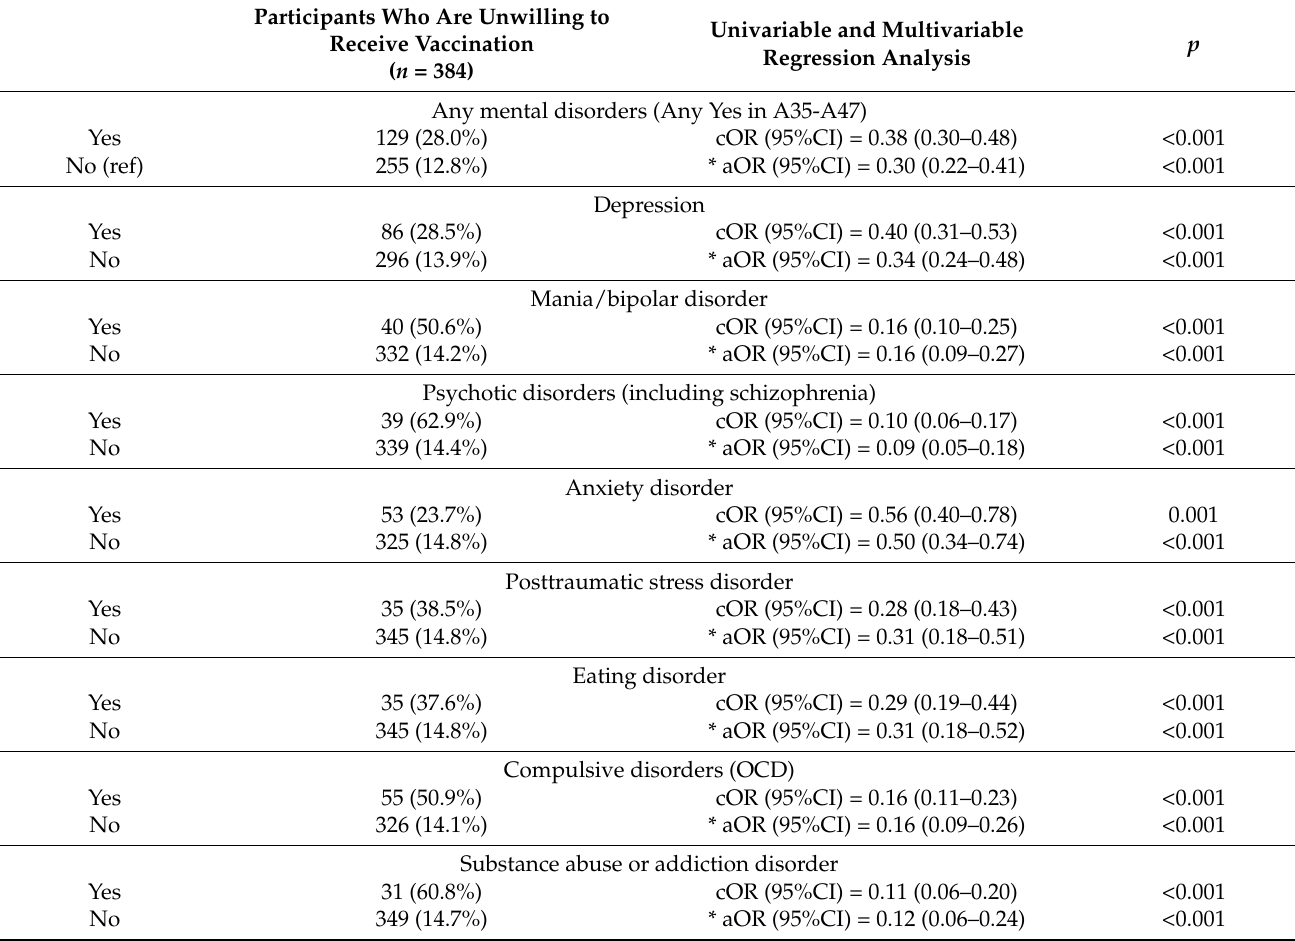
Table 4. Associations between mental disorders and COVID-19 vaccination intention ( n = 2459). Univariable and Multivariable Regression